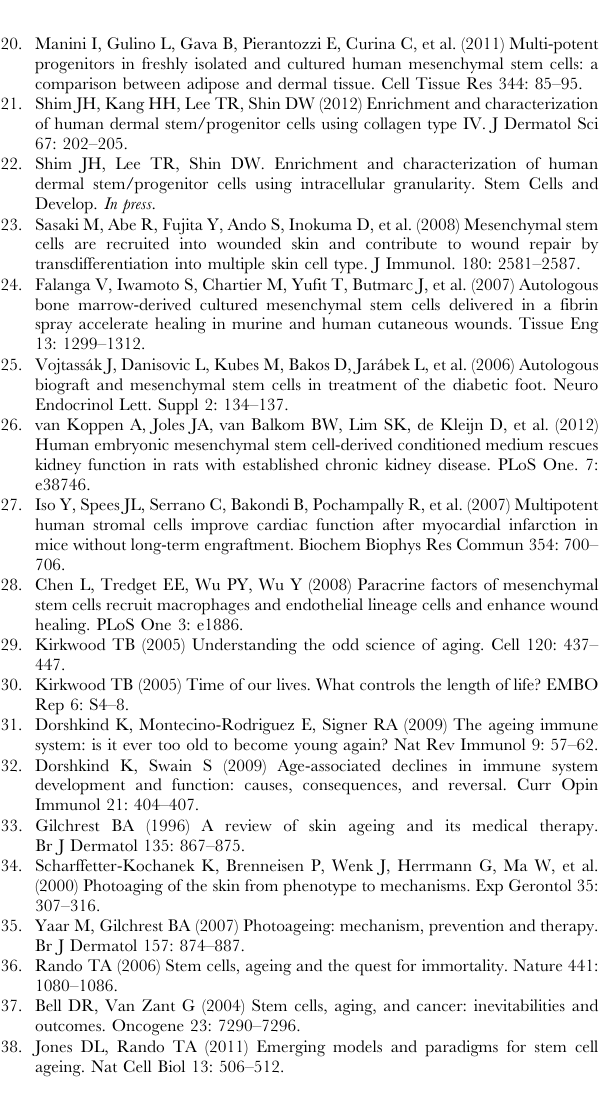
Red assays, which are used to detect H 2 O 2 , in the presence or absence of UVA irradiation using assay buffer or conditioned media from either non-hDSPCs or hDSPCs (A, B) Absorption spectra after irradiation for 0 min (A, B) and 10 min (C, D). The graphs are shown as the mean 6 S.D. of three independent experiments. * p , 0.01 Table S1 Relative cytokine secretion analysis of